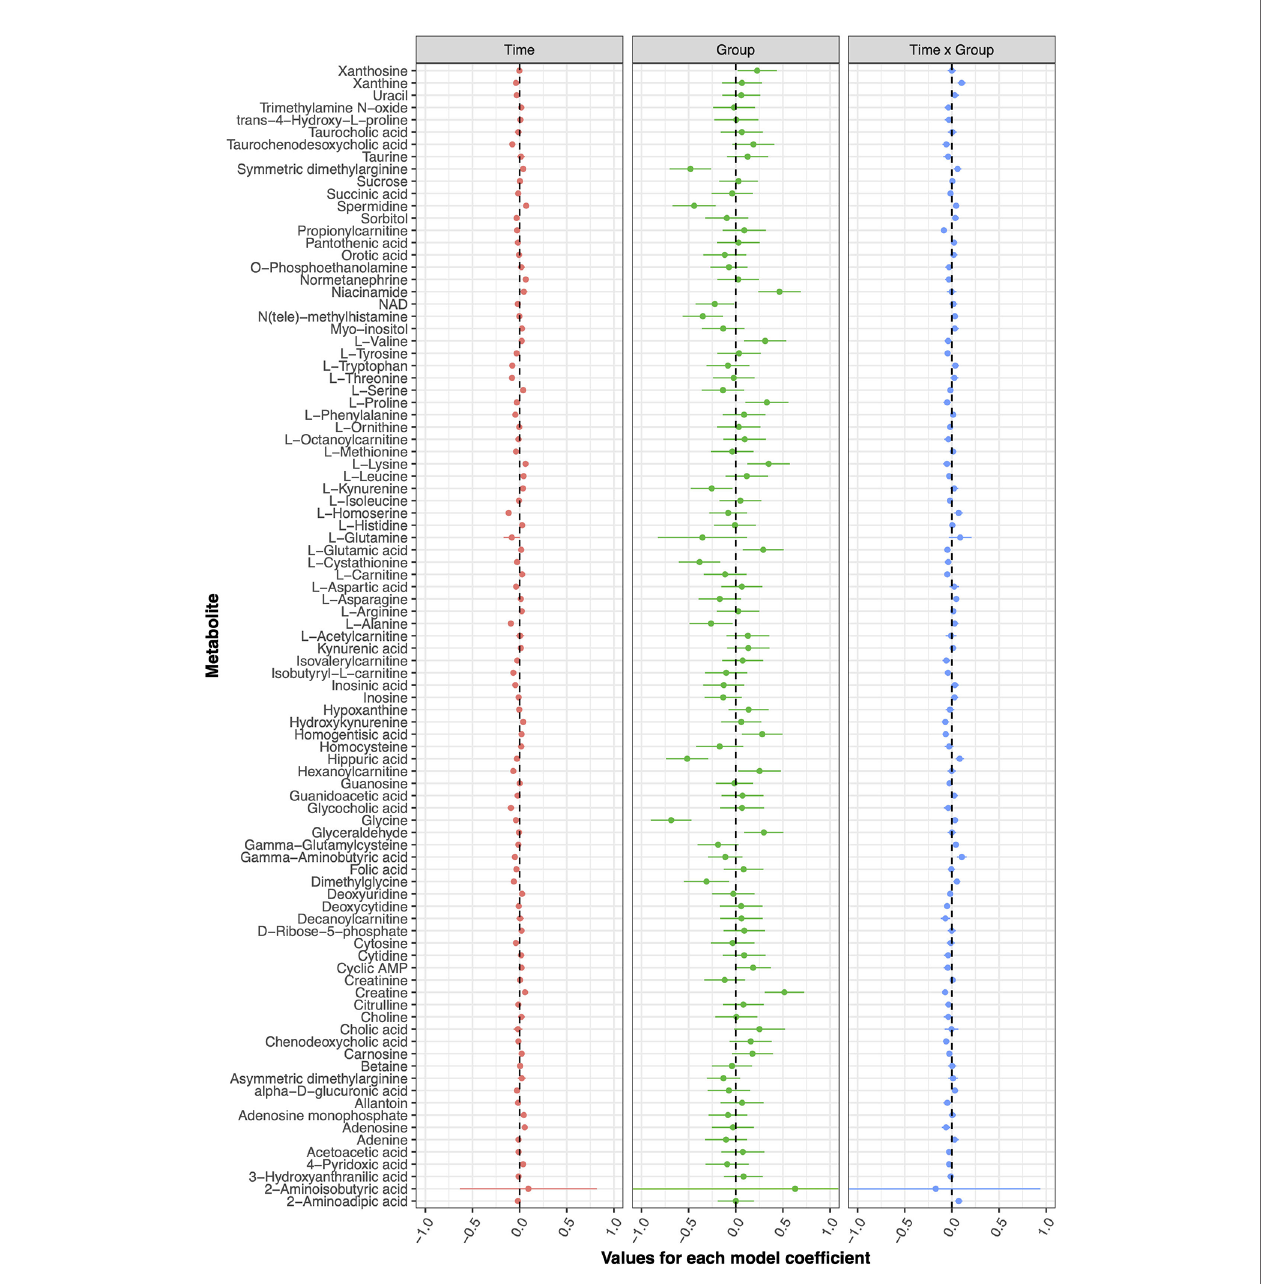
FIGURE 2 | Coef fi cient values with 95% con fi dence intervals from each metabolite model